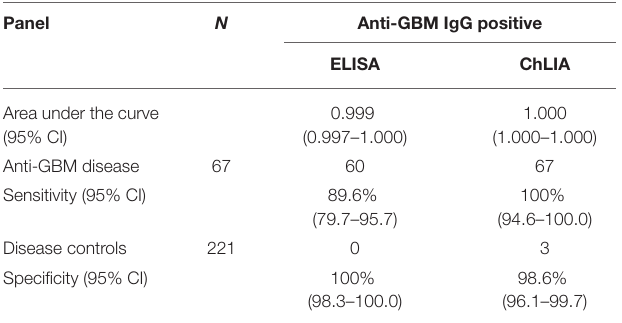
ELISA ChLIA 0.999 (0.997–1.000)